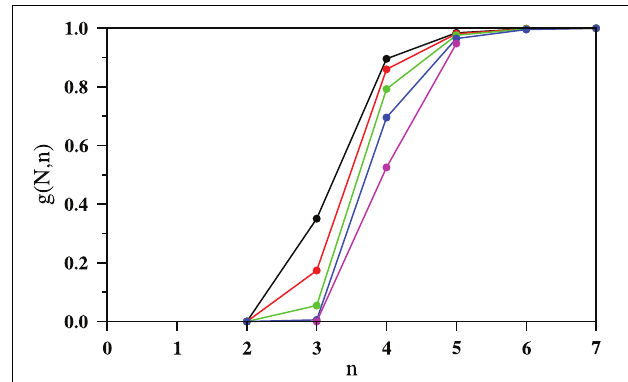
FIGURE 3 | The fractions g ( N , n ) of single component connected graphs, in a sample of 1000 RGGs, are plotted against n . For N agents this fraction grows as the number of neighbors n is gradually increased. System sizes N are 256 (black), 512 (red), 1024 (green), 2048 (blue), and 4096 (magenta), increased from left to right. The number of independent configurations used for each value of n is 1000.